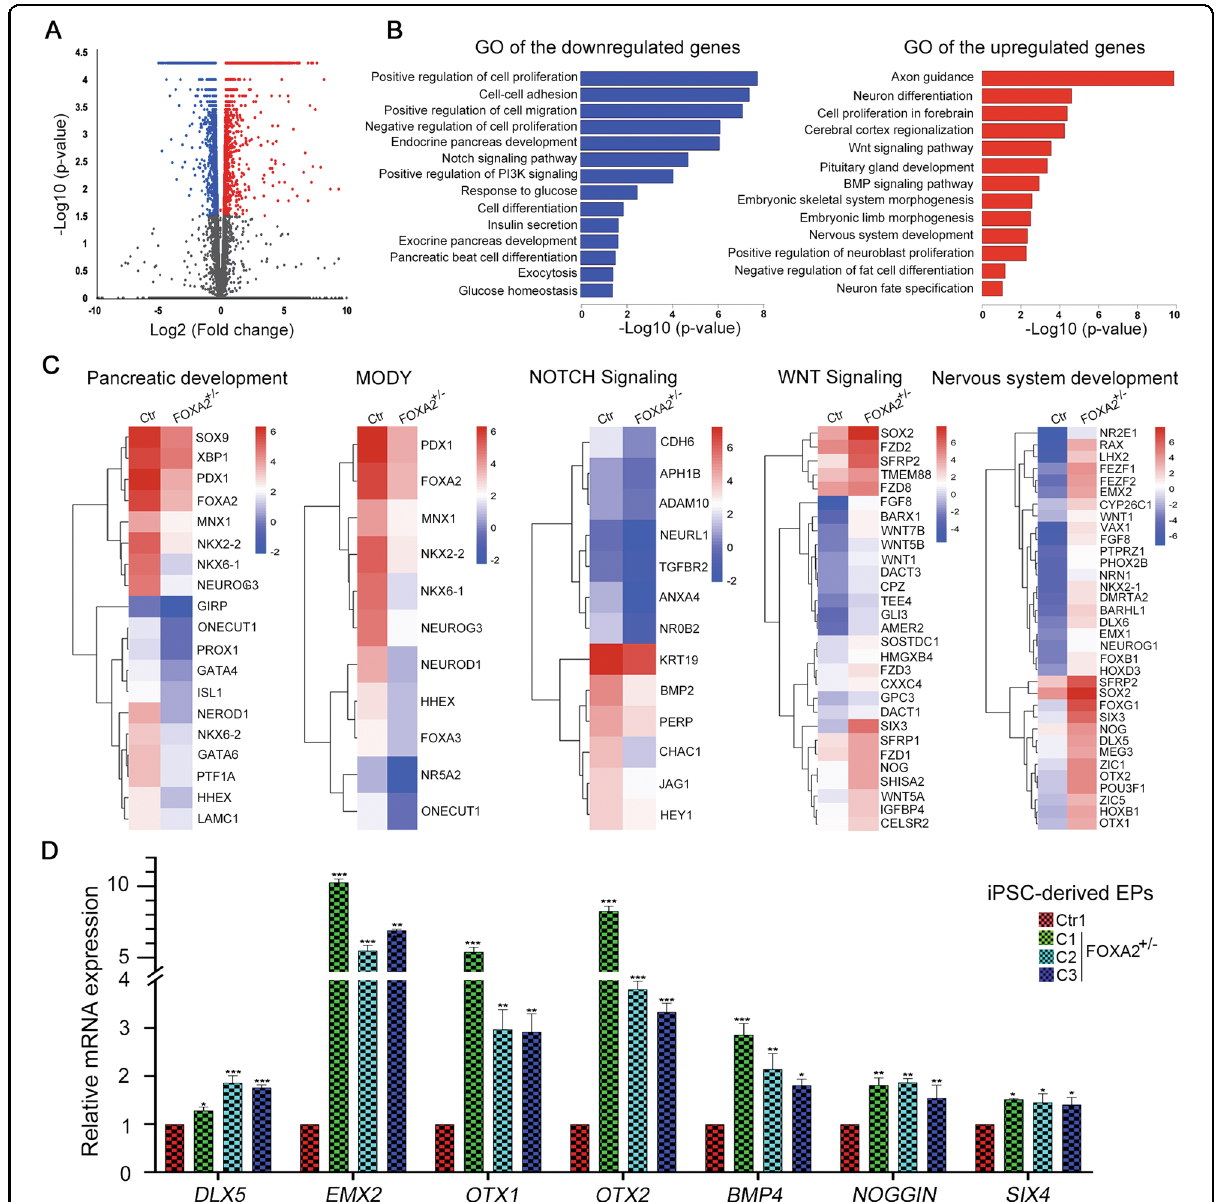
Fig. 5 Transcriptomic changes in pancreatic endocrine progenitors (EPs) derived from FOXA2 + / − iPSCs. A Volcano plot plotting the log2 fold change (FC) and the adjusted p -value for all the transcripts. B Pathway enrichment analysis on upregulated and downregulated differentially expressed genes (DEGs) in FOXA2 + / − iPSC-derived EPs using DAVID function annotation tool. The enriched pathways were plotted against − log10 ( p -value). C Heatmaps of pathway-associated DEGs in FOXA2 + / − iPSC-derived EPs compared to those derived from Ctr-iPSCs. The downregulated genes were associated with pancreatic development, maturity-onset diabetes of the young (MODY), and NOTCH signaling pathways, while the upregulated genes were associated with the WNT signaling pathway and nervous system development. The relative value for each gene is depicted by color intensity, with red indicating upregulated and blue indicating downregulated genes. D RNA-Seq results were validated using qPCR for the upregulated genes associated with WNT signaling and nervous system development. Data are represented as mean ± SD; * p < 0.05, ** p < 0.01, *** p <